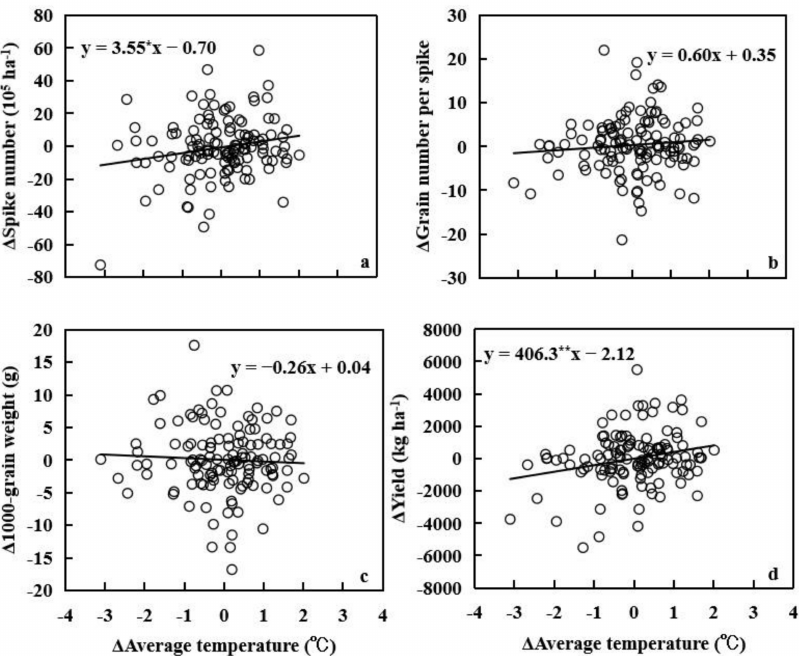
Figure 4. Relationships between year-to-year changes for growing season average temperatures ( ∆ Average temperature) and year-to-year changes for spike number ( ∆ Spike number, a ), grain number per spike ( ∆ Grain number per spike, b ), 1000-grain weight ( ∆ 1000-grain weight, c ) and wheat grain yields ( ∆ Yield, d ). Growing season average temperature was calculated from daily values for entire growing duration from sowing to maturity. Yield and yield components data were obtained from China agro-meteorological experiment stations in which fertilization and irrigation were optimized to achieve the local highest possible yields. ** Significant at p < 0.01; * Significant at p < 0.05.